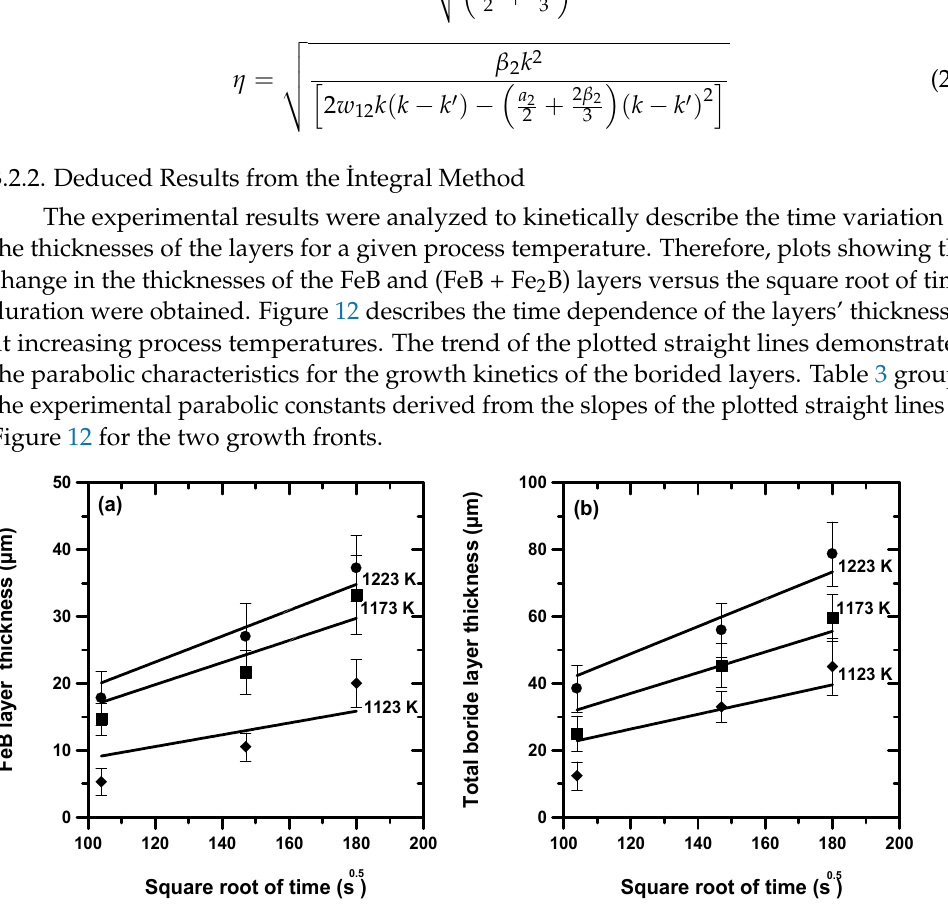
Figure 12. Change in thickness of layers over time for three process temperatures: ( a ) FeB layer, ( b ) (FeB + Fe 2 B). Table 3. Experimental parabolic growth constants deduced from the data of Figure 12.